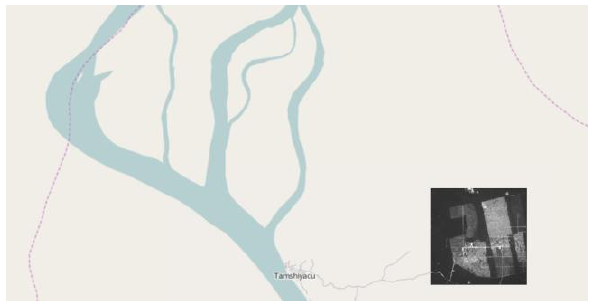
Figure 3. “BLIF” function for the localisation of the RapidEye scene.